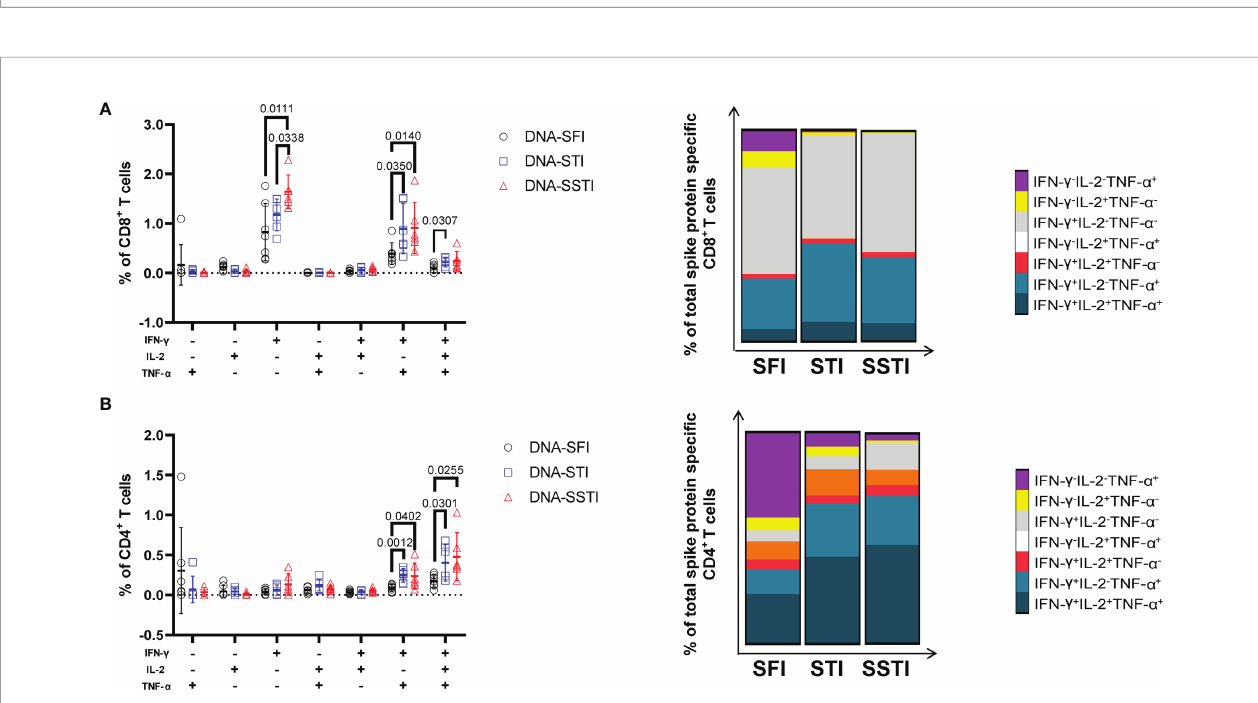
FIGURE 6 | Delineation of multifunctional T cell responses at 5 weeks post 3 rd immunization. Multifunctional CD8 + (A) and CD4 + T (B) cell responses were analyzed using the Boolean gating strategy (FlowJo). The stacked bar plots depict the proportion of each cell population. Data are shown as mean ± SD. Statistical differences among groups were analyzed using t-test.